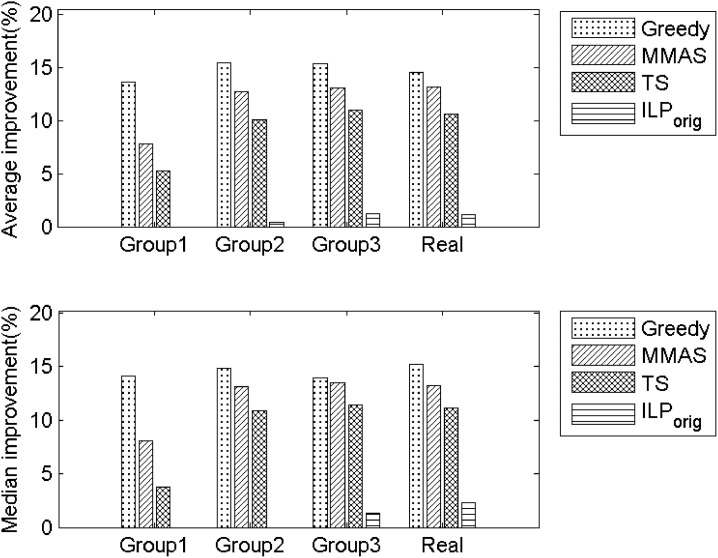
Percentage of improvement of ILPgraph over Greedy, MMAS, TS and ILPorig.Top: Improvement in average solution. Bottom: Improvement in median solutions.